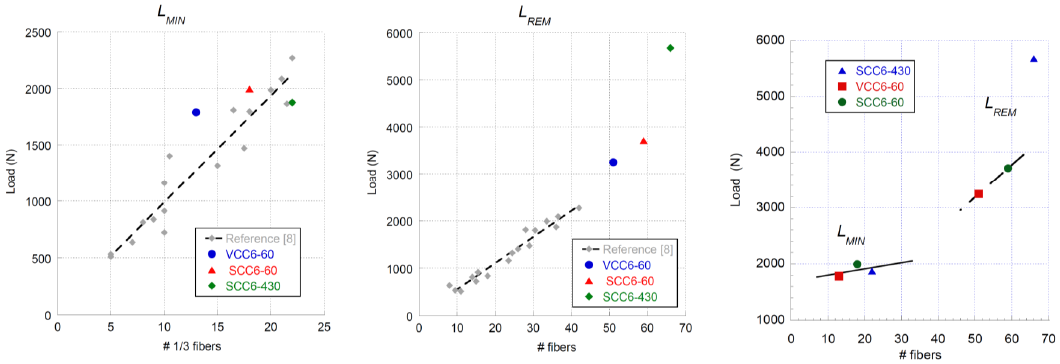
Figure 12. Relation between L MIN and L REM and the number of fibers in the ligament.